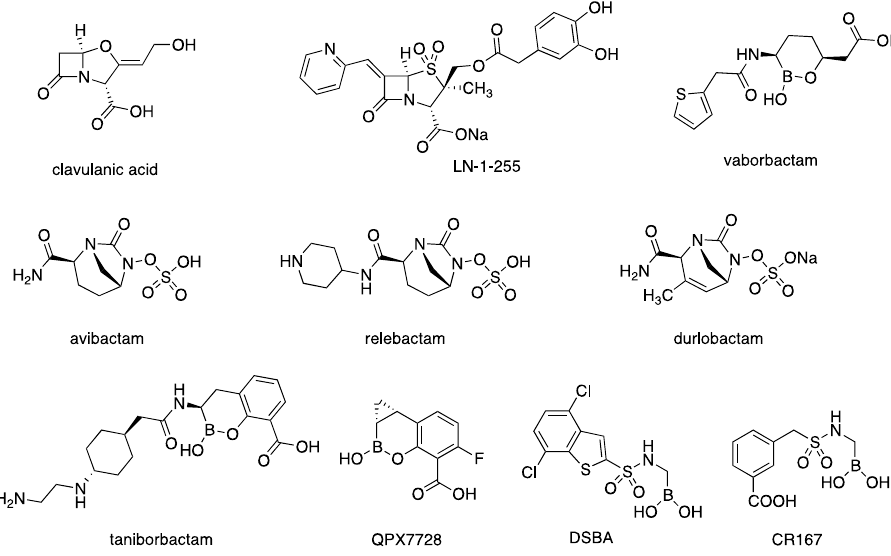
Figure 2. β -Lactamase inhibitors used against A. baumannii Figure 2. β ‐ Lactamase inhibitors used against A. baumannii . Boronic acid transition state inhibitors (BATSIs) have recently been developed as inhibitors of β ‐ lactamases. The nucleophilic attack of the catalytic serine on the boron atom forms a tetrahedral adduct, which mimics the acylation (or deacylation) tetrahedral structure of the high ‐ energy intermediate formed during β ‐ lactam hydrolysis. Boronic acids are known to inhibit class A and class C β ‐ lactamases with K i values in the nM range [20,21], while relatively few compounds demonstrate activity against class D enzymes [22–24]. The first BATSI to reach the market, vaborbactam, is a mono ‐ cyclic boronic acid (Figure 2) that has proved to be an excellent class A and C β ‐ lactamase inhibitor, although it is not active against class D enzymes [19]. However, the bicyclic boronate core structure exhibits cross ‐ class inhibition, with two such inhibitors, QPX7728 and taniborbactam, currently in phase 1 and phase 3 clinical trials, respectively [25,26]. Other studies demonstrated the ability of select boronic acids to inhibit OXA enzymes [22,27,28], but none were further developed. In 2010, the work performed by Tan et al. revealed the activity of arylsulfonamide boronic acids to be in the low μ M range against five different β ‐ lactamases [22]. In particular, the 4,7 ‐ dichloro ‐ 1 ‐ benzothien ‐ 2 ‐ yl ‐ sulfonylaminomethyl boronic acid (DSABA, Figure 2) demonstrated improved affinity for OXA ‐ 24/40 (IC 50 = 5.6 μ M), while also inhibiting class A and C β ‐ lactamases with sub ‐ to low μ M IC 50 values. Other sulfonamide boronic acids have proved to be excellent inhibitors of the class C β ‐ lactamase AmpC from E. coli , displaying a distinct structure–activity relationship when compared with the better characterized carboxamides. Amongst the different benzyl sulfonamide derivatives, CR167 (Figure 2) , bearing a carboxylate in the meta position of the aromatic ring, has emerged as one of the most potent AmpC inhibitors ( K i = 1.3 nM) [29,30]. The compound was also tested against class A enzymes and proved to have potent activity against SHV ‐ 1 (IC 50 = 0.43 μ M) and KPC ‐ 2 (IC 50 = 0.20 μ M) β ‐ lactamases [31]. Encouraged by the results obtained against class A and C β ‐ lactamases, CR167 was tested against an important ADC variant found in A. baumannii . The compound demonstrated enhanced affinity for ADC ‐ 7 with a K i = 160 nM and proved to be able to decrease MIC values of CAZ (reducing the MIC for CAZ in E. coli DH10B pBCSK, bla ADC ‐ 7 from 64 mg/L to 1 mg/L) [32]. The X ‐ ray structure of the complex ADC ‐ 7/ CR167 (PDB 5WAE) was obtained and the mechanism by which this inhibitor extends into the R1 binding site, where the side chain at C7 of the cephalosporin interacts, was demonstrated.